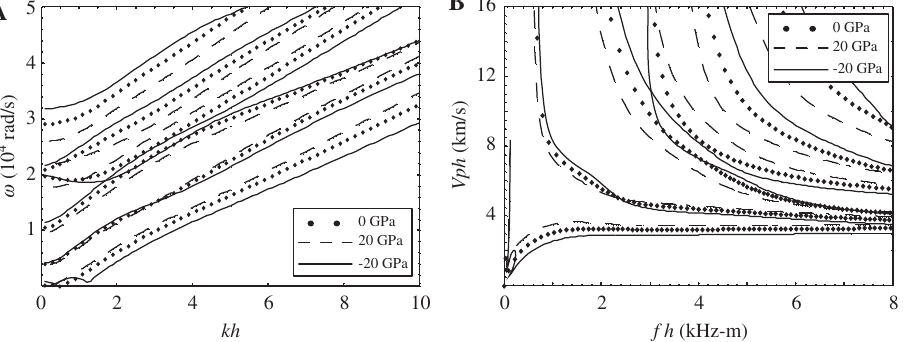
Figure 4 Circumferential Lamb-like wave dispersion curves for the sinusoidally graded cylindrical plate with η = 2 under different radial initial stresses: (A) frequency spectra, (B) phase velocity spectra.